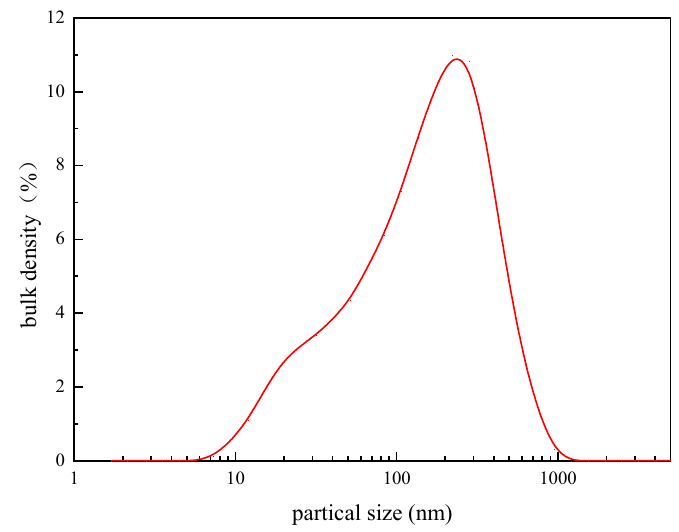
Figure 8. PAASM-CaCO 3 particle size distribution.